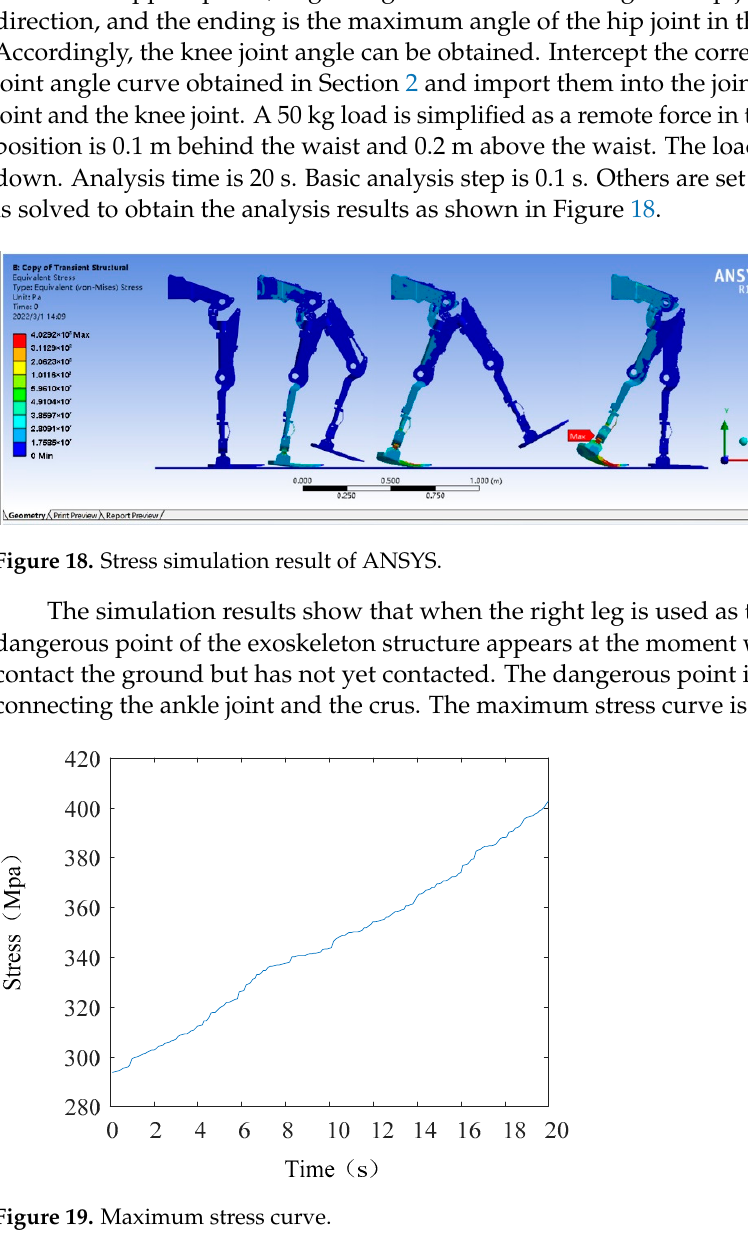
Figure 17. The setting of the ANSYS model.